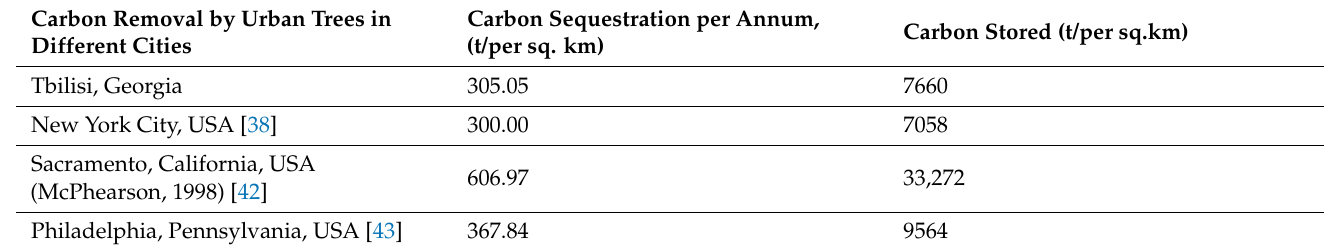
Table 5. Carbon removal by urban trees in different cities.